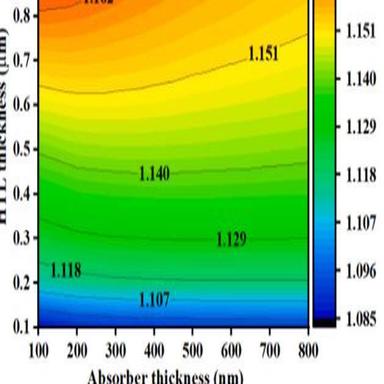
Contour mapping of Voc for FASnI3 absorber and HTLs thickness (a) CBTS (b) CFTS (c) Cu2O (d) CuI (e) CuO (f) CuSbS2 (g) CuSCN.